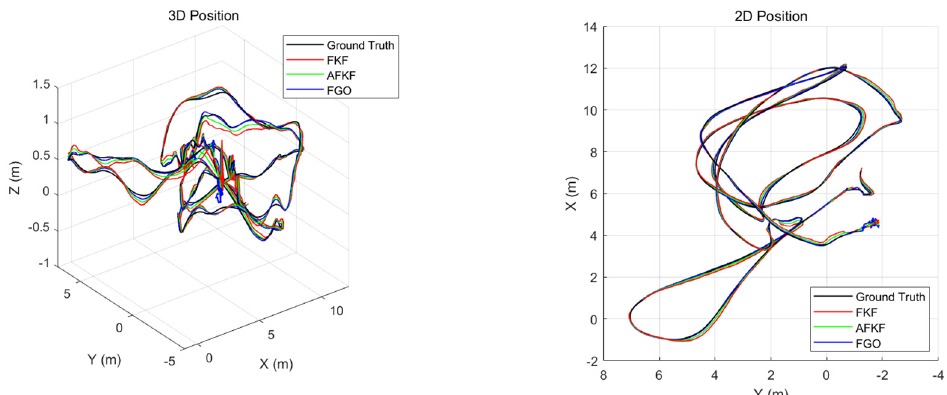
Figure 15. Comparison of 3D position and 2D position of different algorithms in MH_03_medium scene.